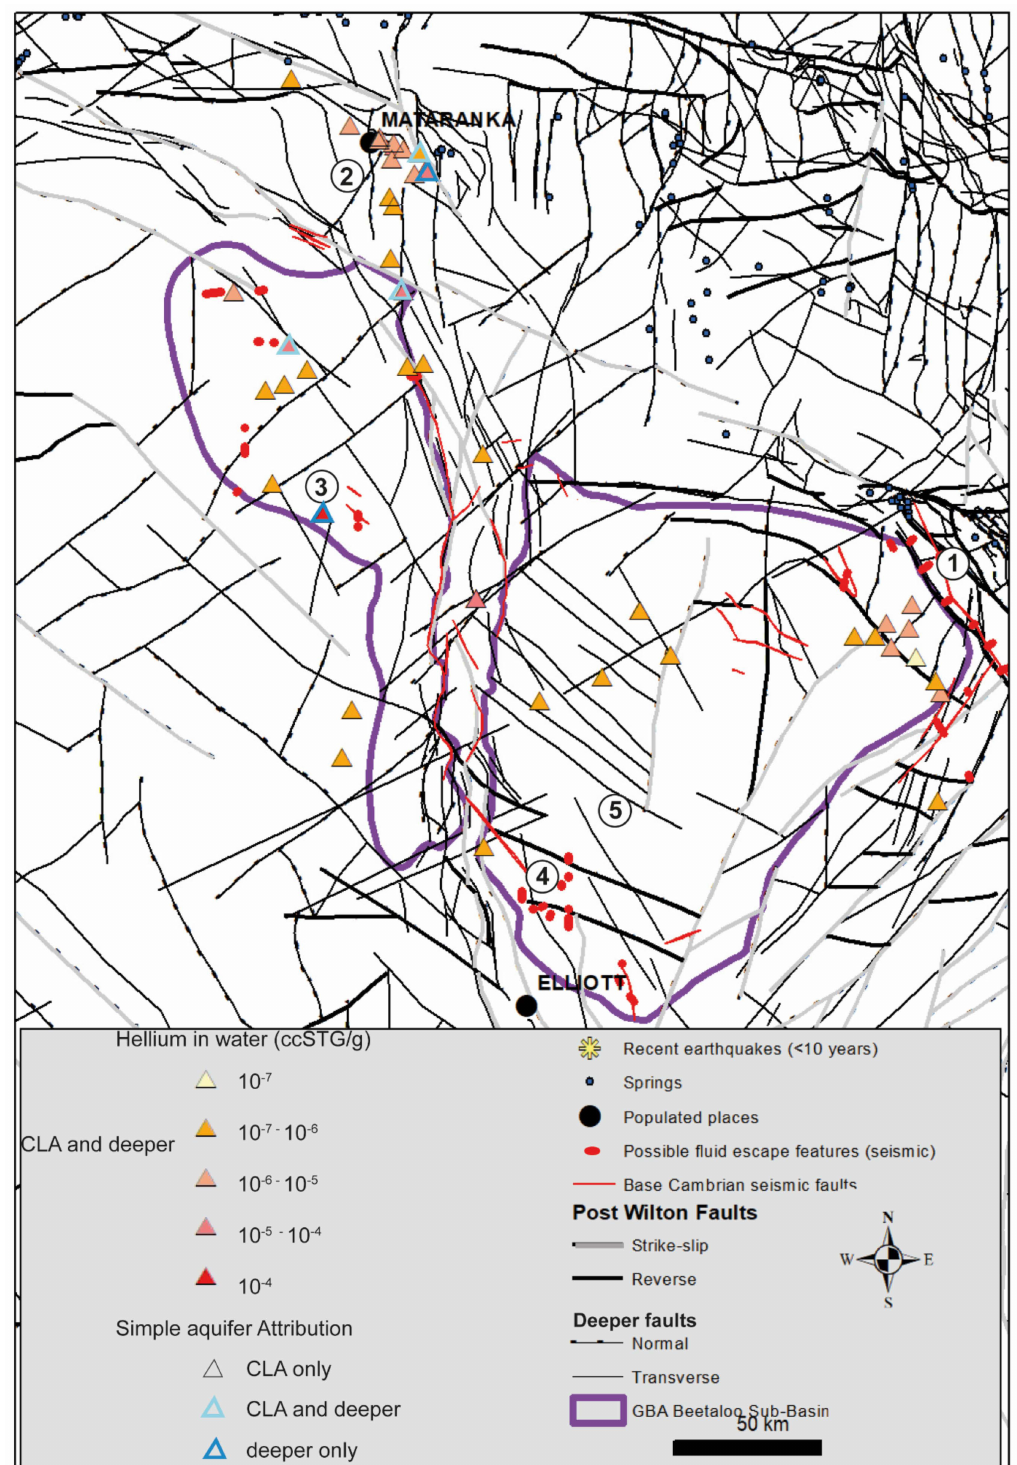
Figure 8. Potential current and post-Cambrian paleo fluid flow (1 to 5) associated with fault pathways. Compilation of this article datasets. 1 OT Downs fault zone, 2. Mataranka and Birdum Creek Fault, 3. Western Beetaloo Sub-basin, 4. southern part of the eastern Beetaloo Sub-basin, 5. Central part of the eastern Beetaloo